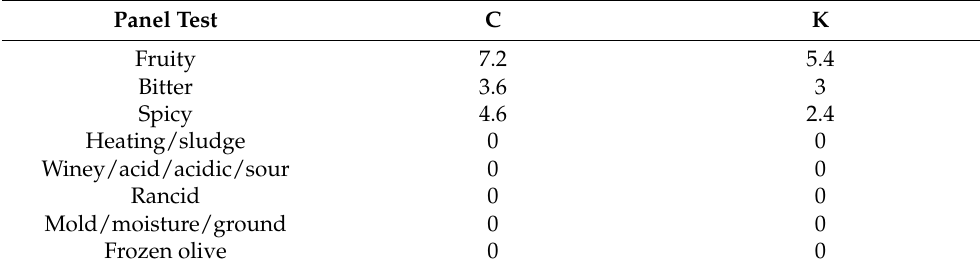
Table 4. Results of oils panel test with kaolin treatment (K) compared with control (C). Panel Test C K Fruity 7.2